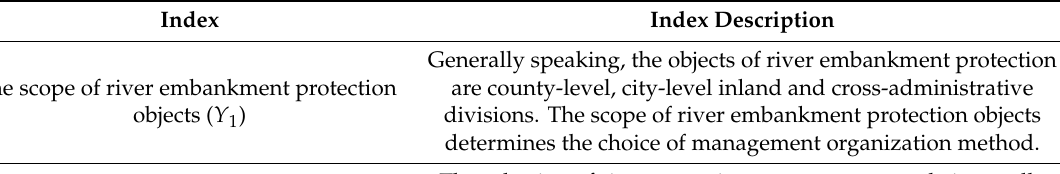
Table 5. Index system for the selection of the river operation management